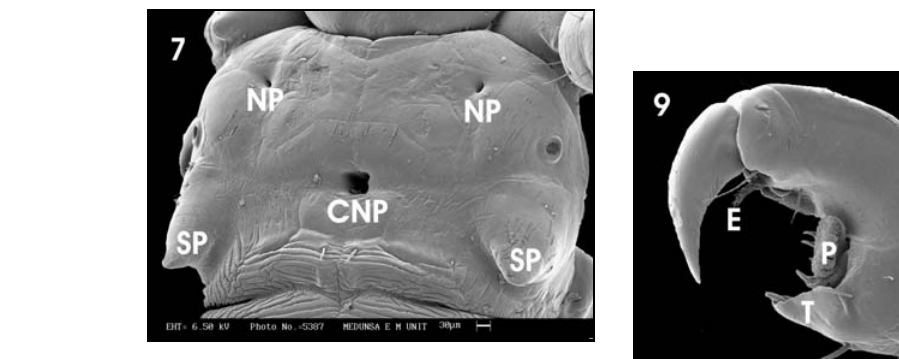
Fig. 7. A dorsal view of the fused pro, mesa and metathorax showing two notal pits (NP) on the pro- thorax and a central notal pit (CNP) on the mesotho- rax. Two spinous processes (SP) protruded towards the rear.